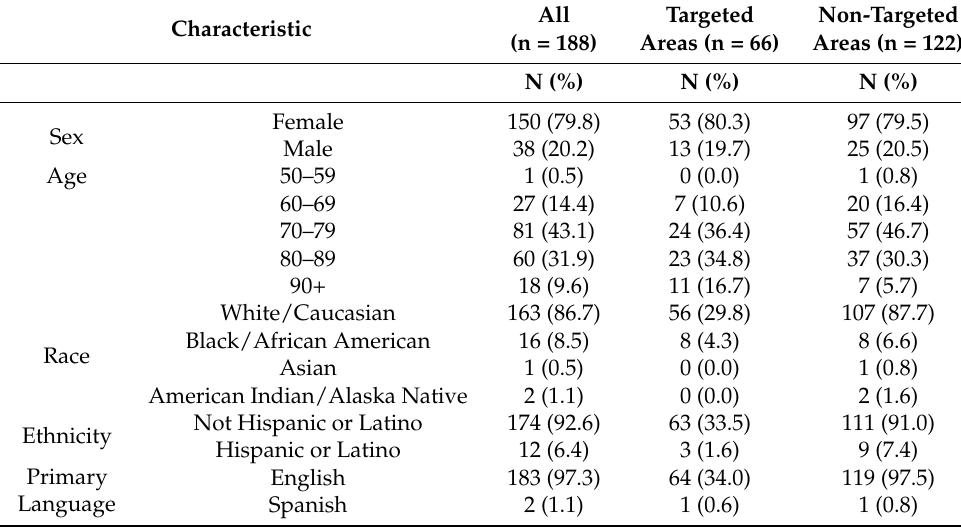
Table 3. Demographic characteristics of participants completing